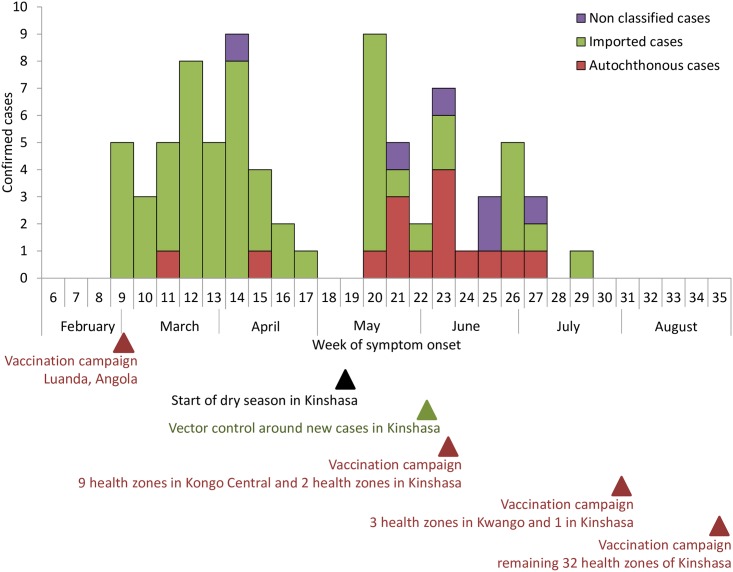
Weekly distribution of confirmed imported, autochtonous and non classified yellow fever cases, DRC, 2016.